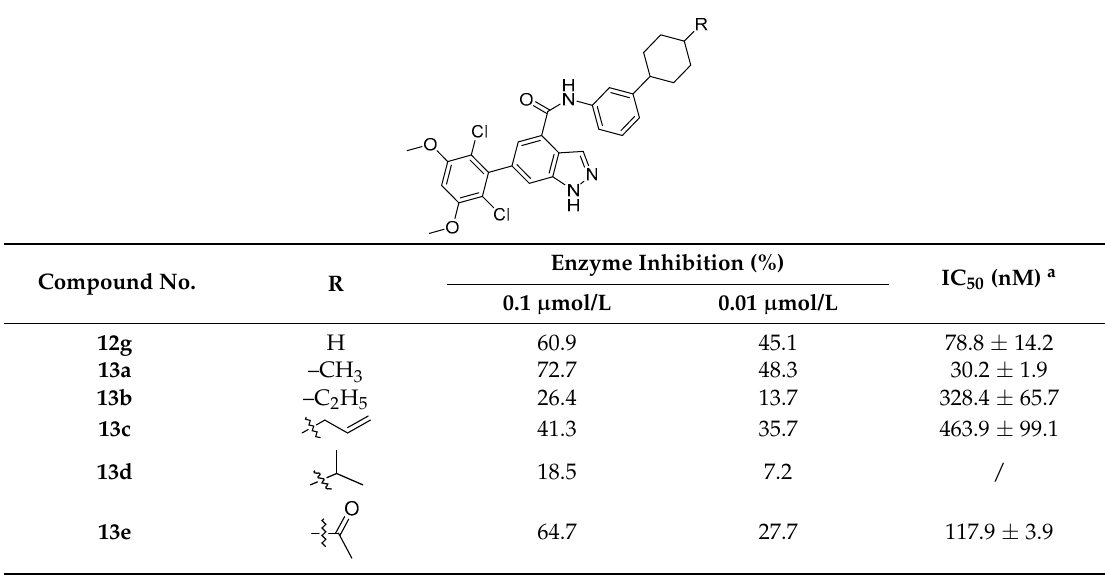
Table 4. Structures and activities of indazole derivatives 13a – e .